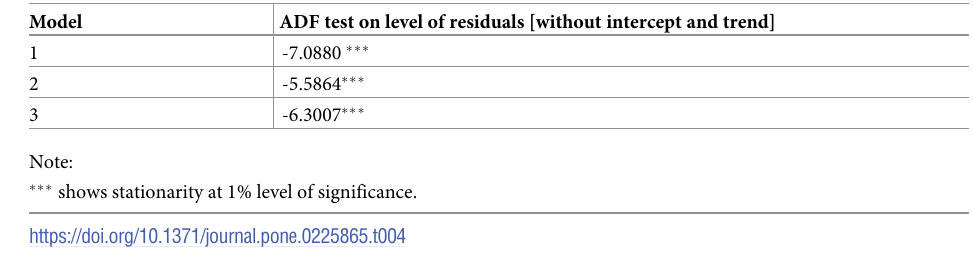
Table 4. Residuals from estimated